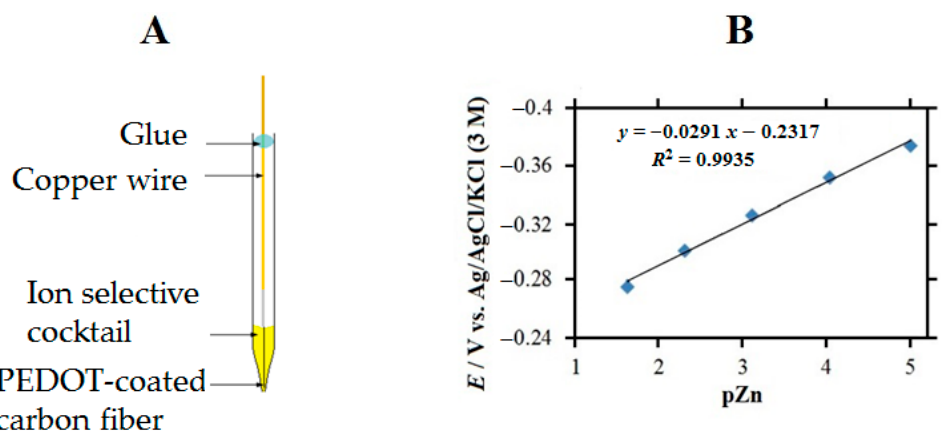
Figure 3. ( A ) Schematic and ( B ) calibration curve of a single-barrel Zn-ISME with internal solid contact.